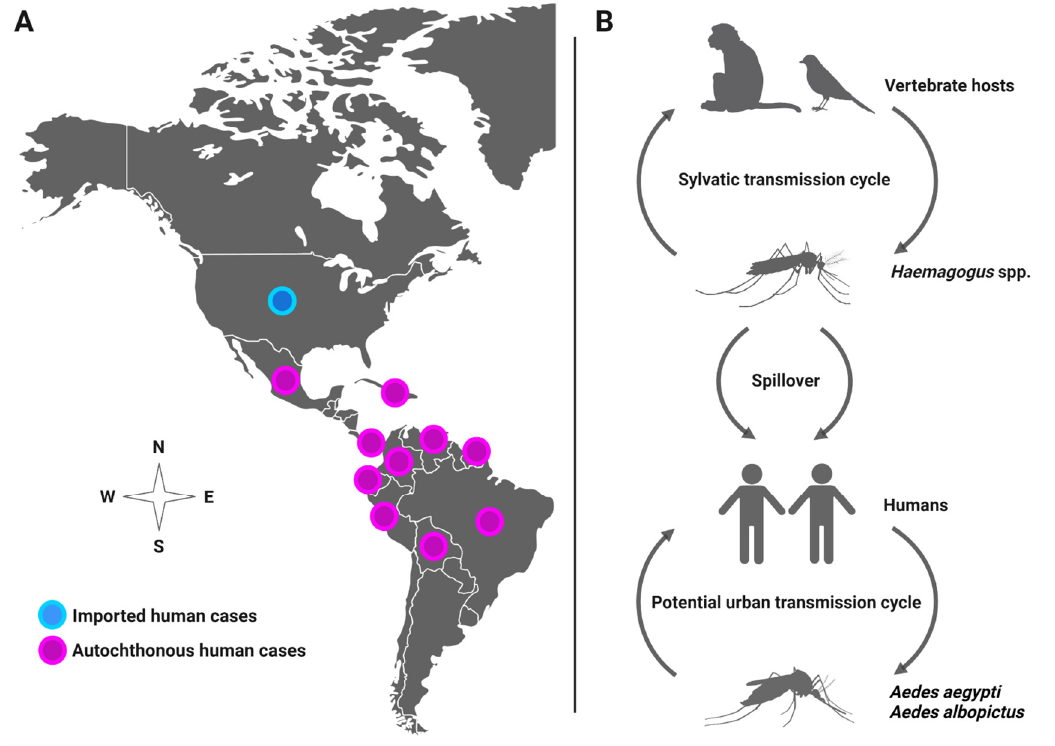
Figure 1. ( A ) Distribution of MAYV in the Americas. ( B ) Potential transmission cycles of MAYV.